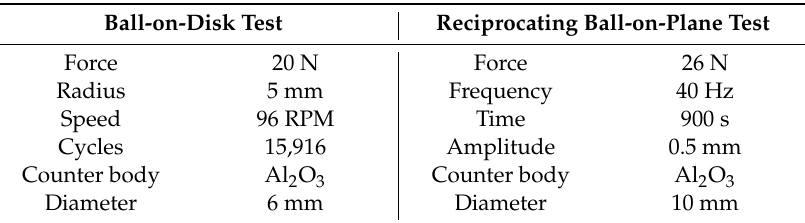
Table 2. Parameters of the conducted wear